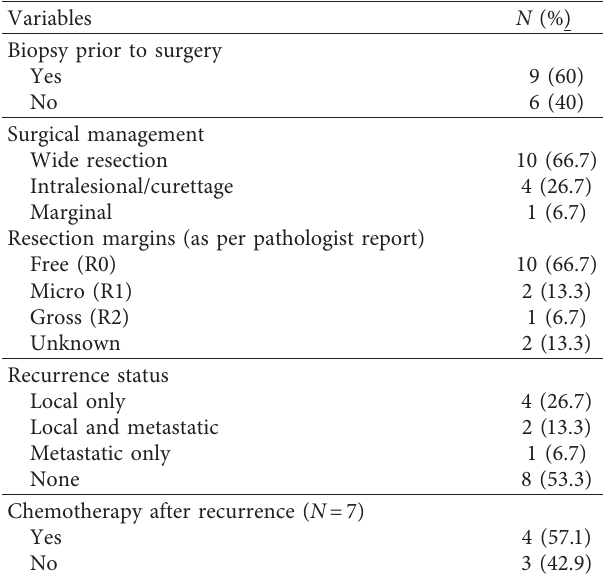
Table 2: Treatment characteristics.